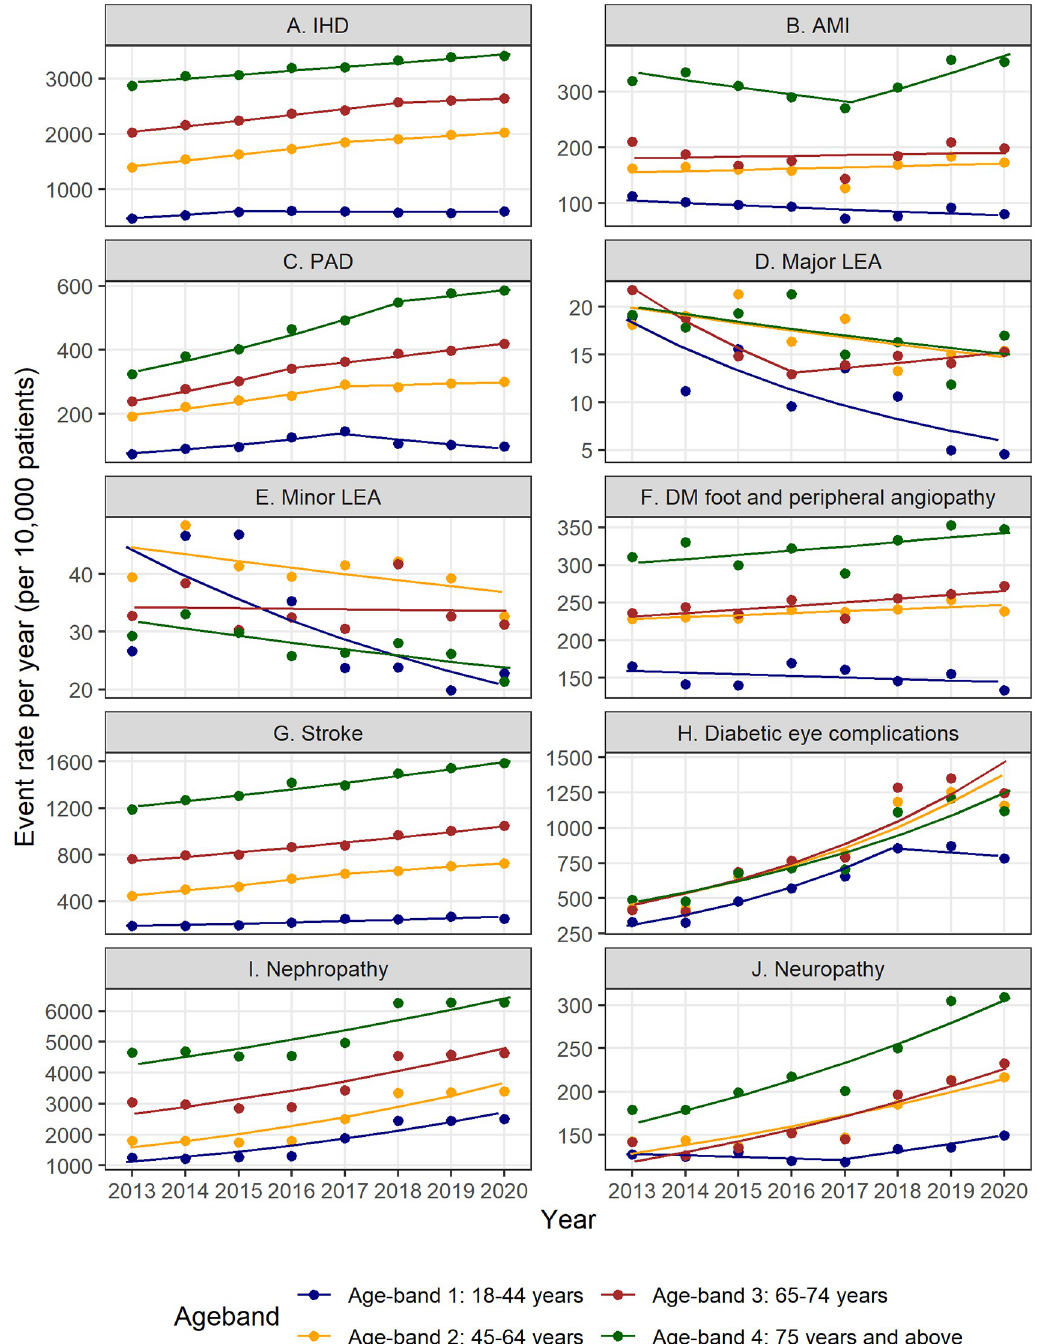
Fig 1. Trends in diabetes complications rates by age-bands. Event rates for (A) ischemic heart disease, (B) acute myocardial infraction, (C) peripheral arterial disease, (D) major LEA, (E) minor LEA, (F) diabetic foot and peripheral angiopathy, (G) stroke, (H) diabetic eye complications, (I) nephropathy and (J) neuropathy. Dots are observed event rates. Solid lines are modeled event rates from the Joinpoint regression analysis.